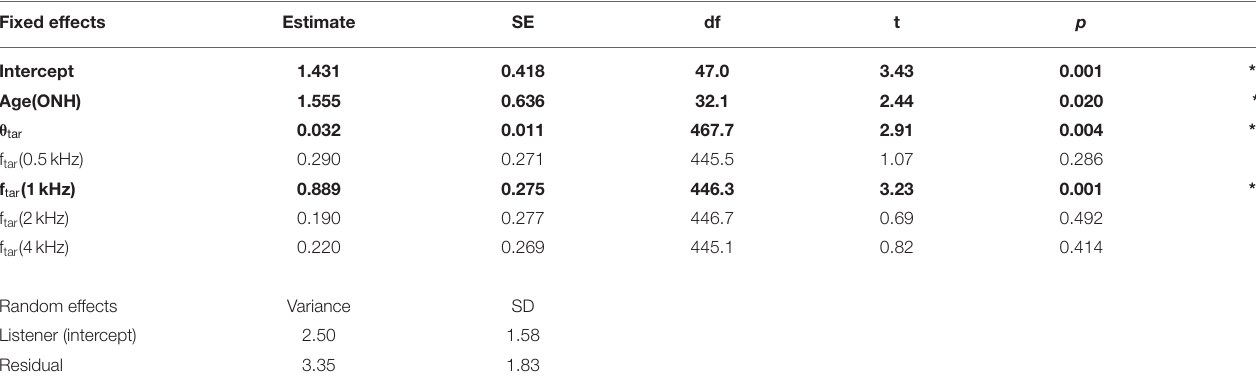
TABLE 1 | Results of the linear mixed-effect model for the ILD thresholds for single